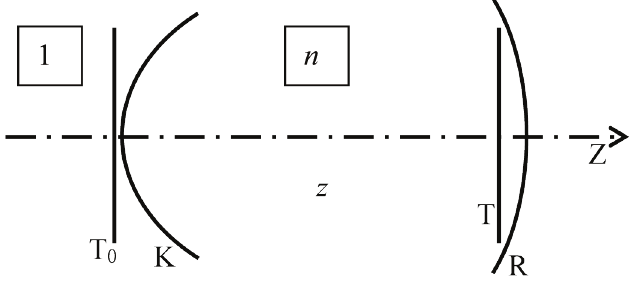
Figure 2 A reduced eye consisting of a refracting surface K of curvature K and a homogeneous medium of length z and index n . The optical system of the eye is from the entrance plane T 0 , im- mediately in front of the cornea, to the exit plane T, immediately in front of the retina R. Z is a longitudinal axis. The medium in front of the eye is air with index